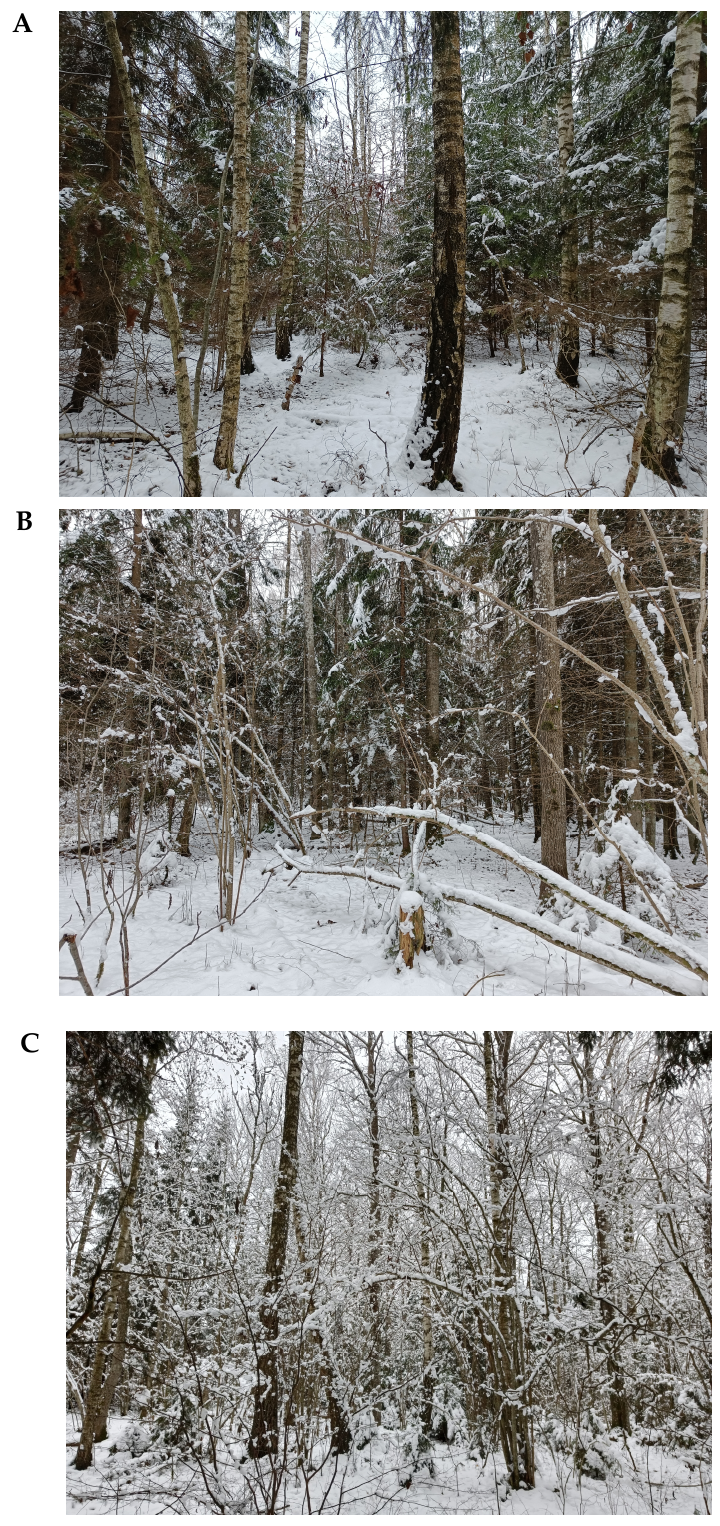
Figure 2. Undergrowth cover under the canopy of deciduous forests: pure Betula spp. forest with Picea abies in the second story and a low-density Corylus avellana undergrowth ( A ); low mixed Populus tremula forest with Picea abies in the second story and medium density Corylus avellana undergrowth ( B ); and mixed Populus tremula forest with dense Corylus avellana undergrowth ( C ) (Photos: Marius Šilingas).